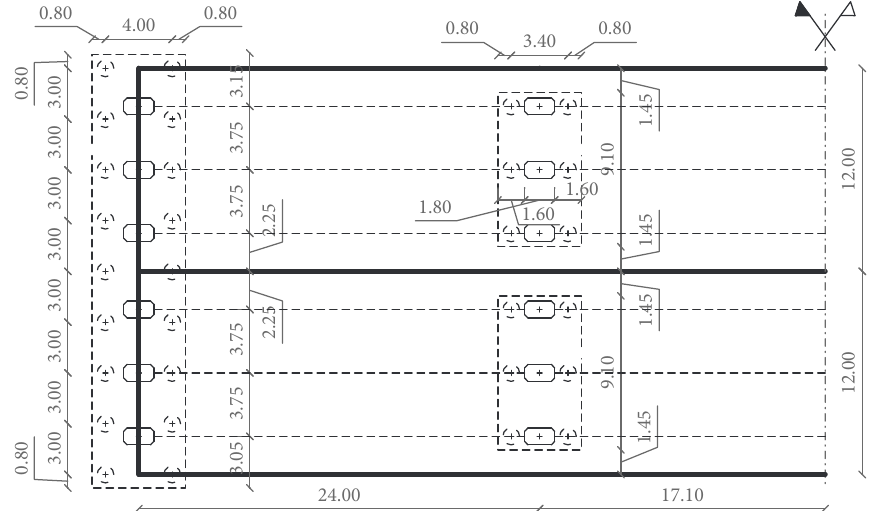
Figure 4: Plan view of deck, columns cross-section, and foundations.